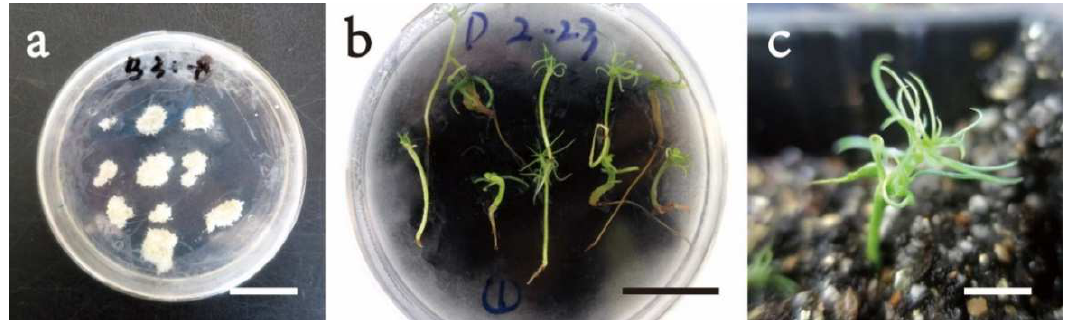
Figure 8. Recovery culture and seedling development in Picea pungens SE: ( a ) proliferated embryogenesis tissues recovered from cryopreserved tissues which were pre-treated with 0.4 mol/L sorbitol for 24 h and 5.0% DMSO; ( b ) embryo germination; and ( c ) growing embryo seedling. Bars: ( a ) = 4 cm, ( b ) = 4 cm, ( c ) = 2